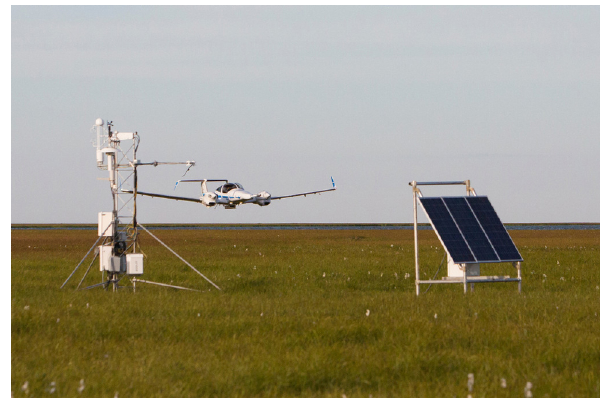
Figure 1. Picture of the FOCAL system flying near the NOAA/ATDD flux tower in North Slope,